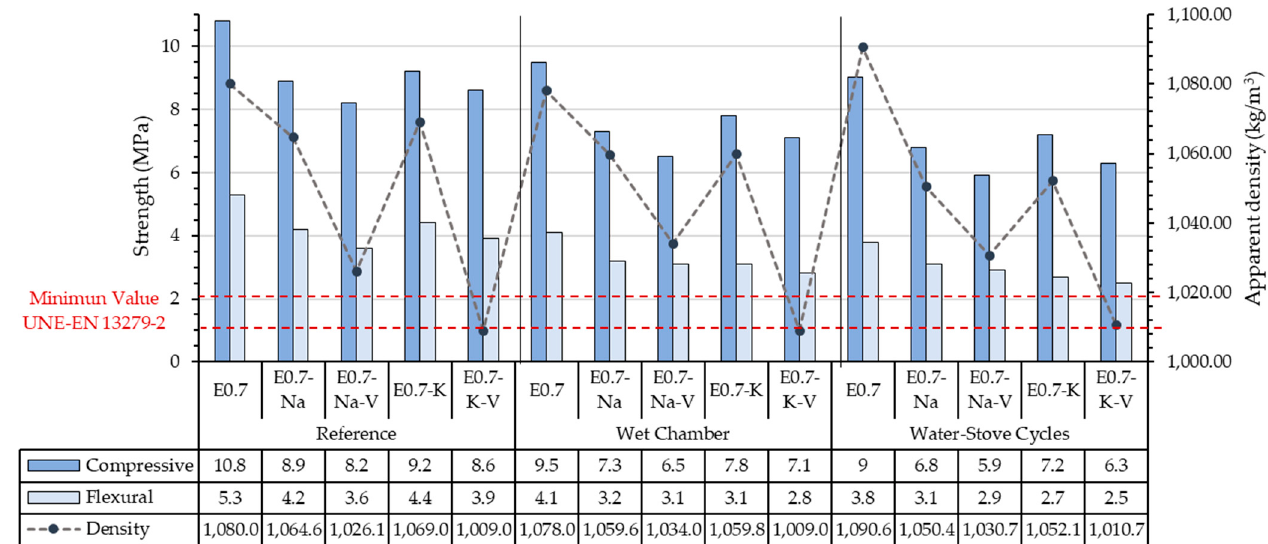
Figure 8. Results evaluation and comparison.